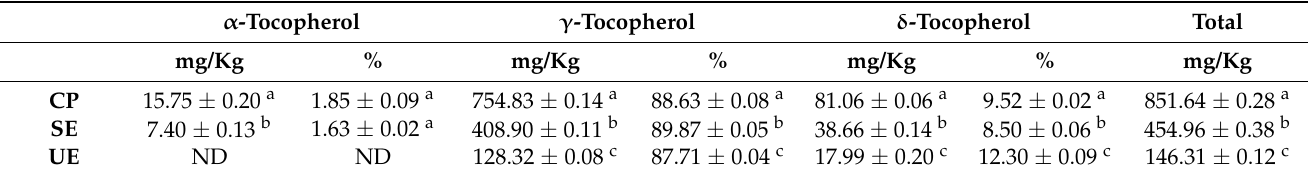
Table 4. Tocopherols Compound Context (mg/kg and %) of walnut seed oils (Mean ± SE). α -Tocopherol γ -Tocopherol δ -Tocopherol